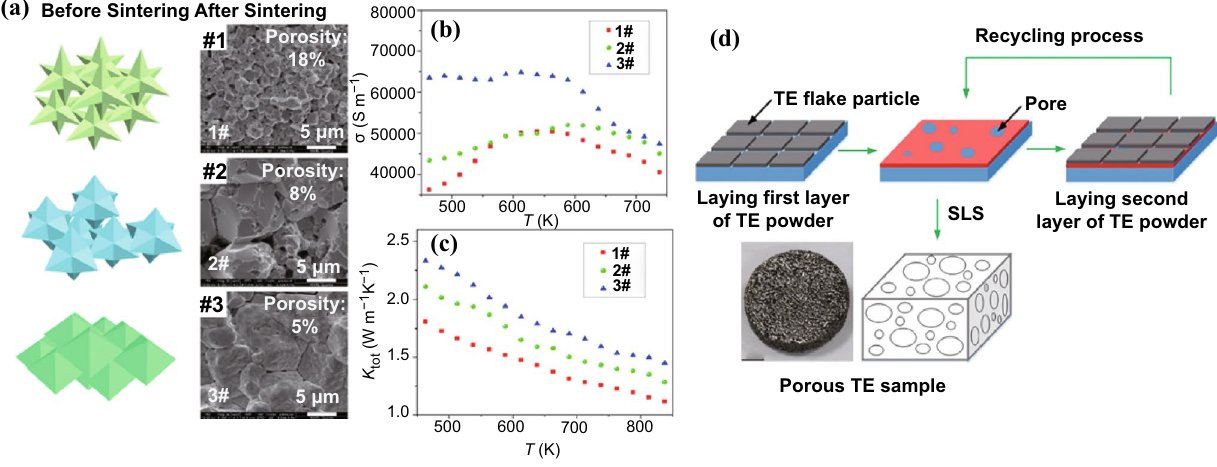
Fig. 15 a Schematic illustration (left) and SEM images (right) of the as-sintered porous monoliths from 1# (hexapods), 2# (less-protruding hexapods) and 3# (octahedra) PbS nanocrystals. Temperature dependence of b σ and c κ of the three sintered TE monoliths. d Schematic dia- gram of selective laser sintering 3D printing process to prepare porous TE monoliths. Adapted with permission from Refs. [207,